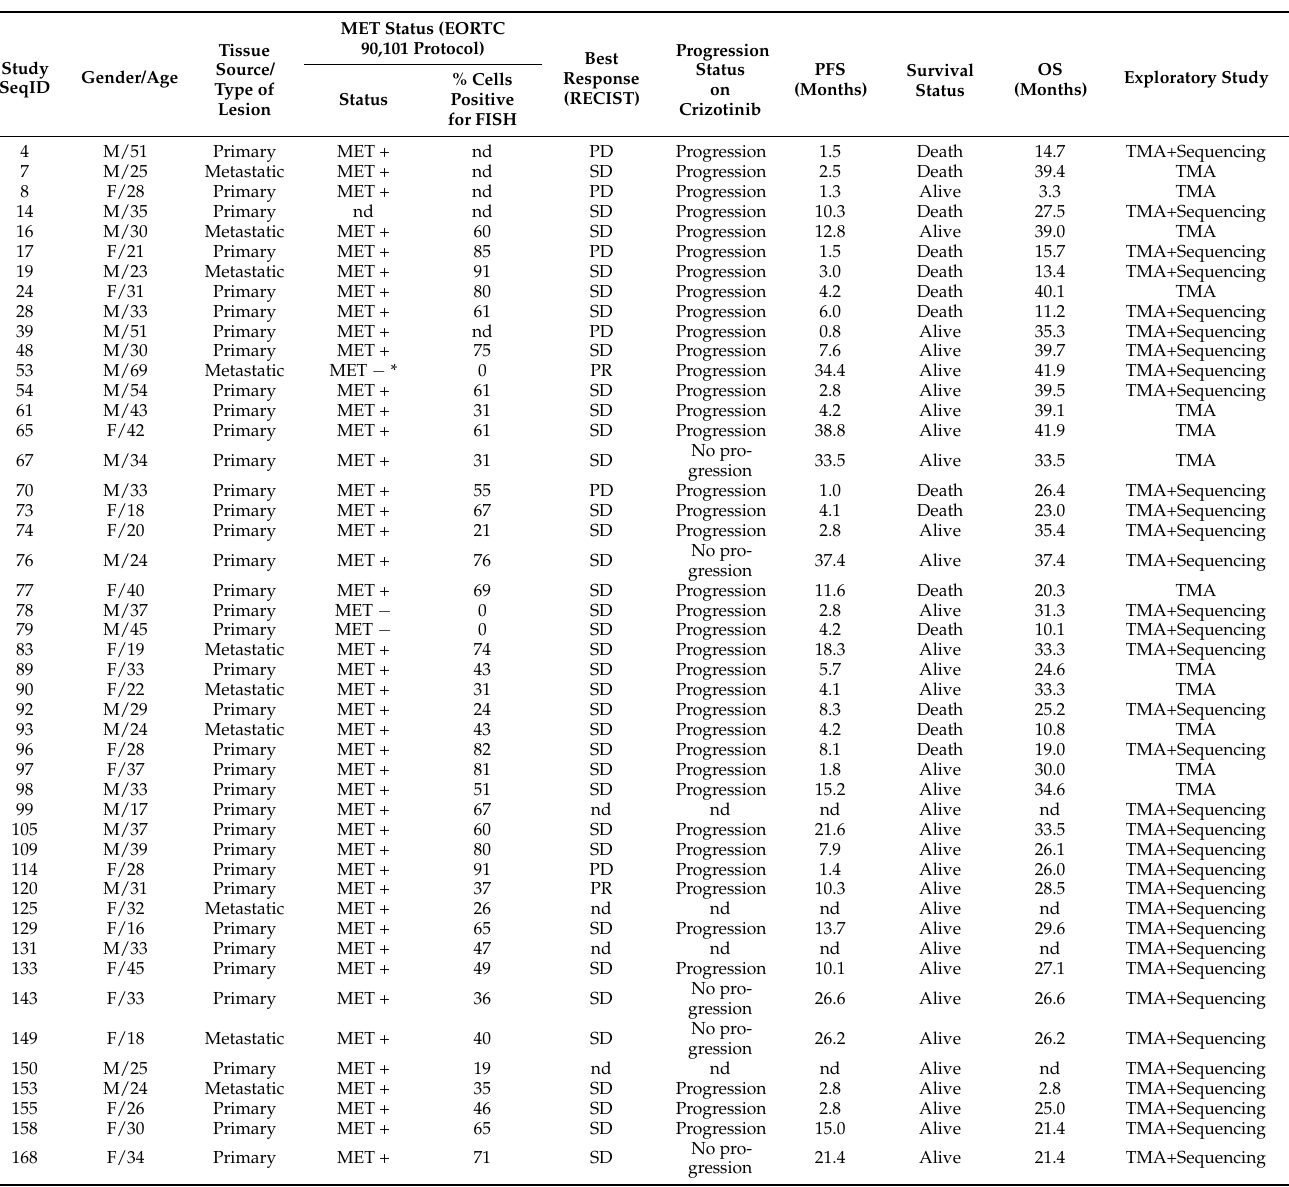
Table 1. Patient characteristics and availability of biological